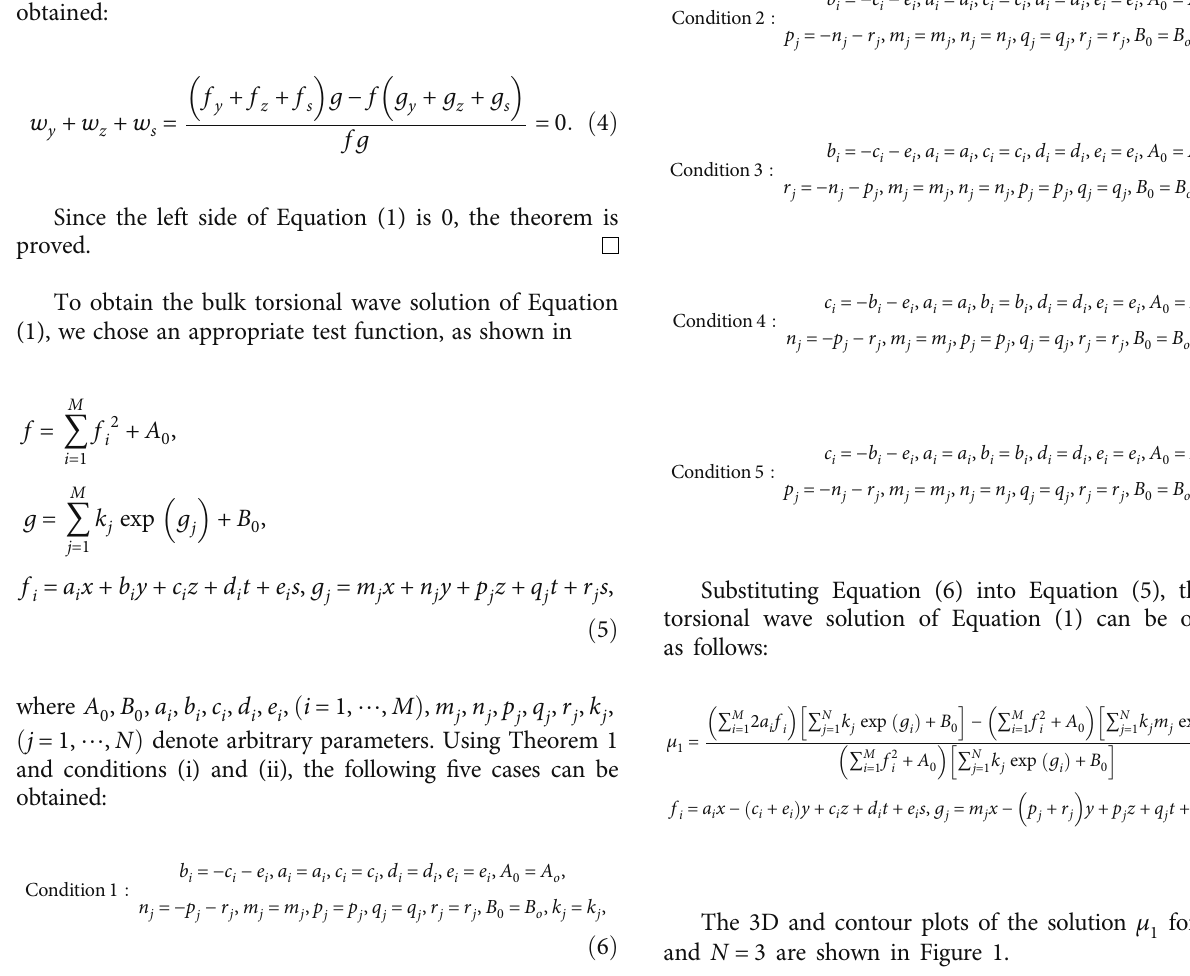
= n = q = r = 2, m 2 2 2 2